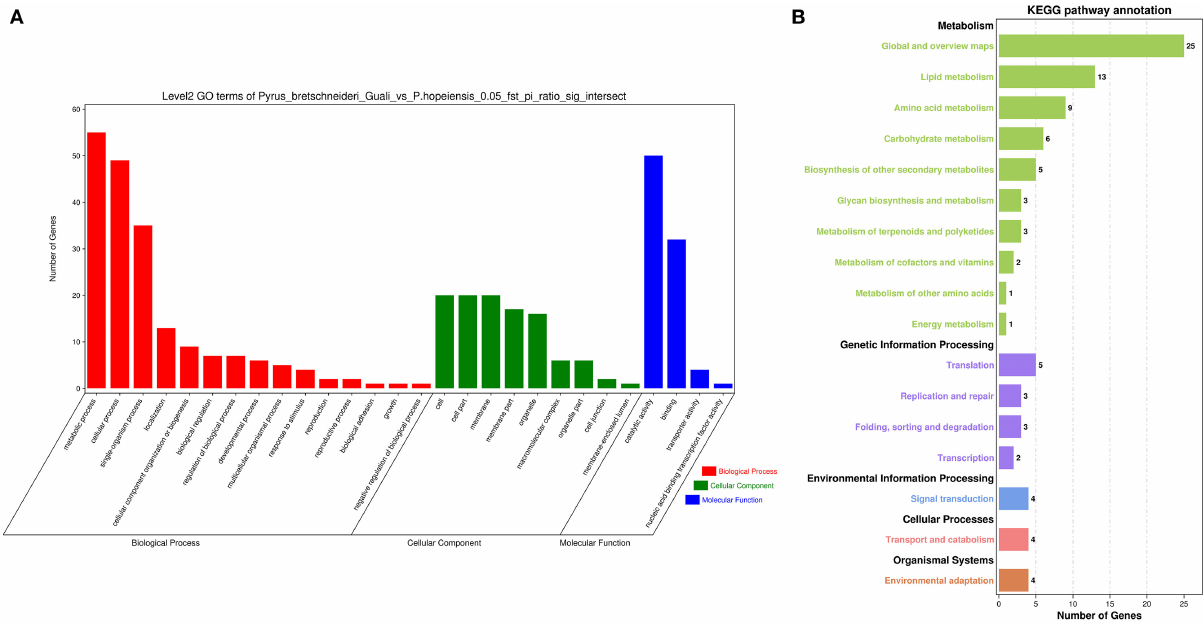
Frontiers in Plant Science |